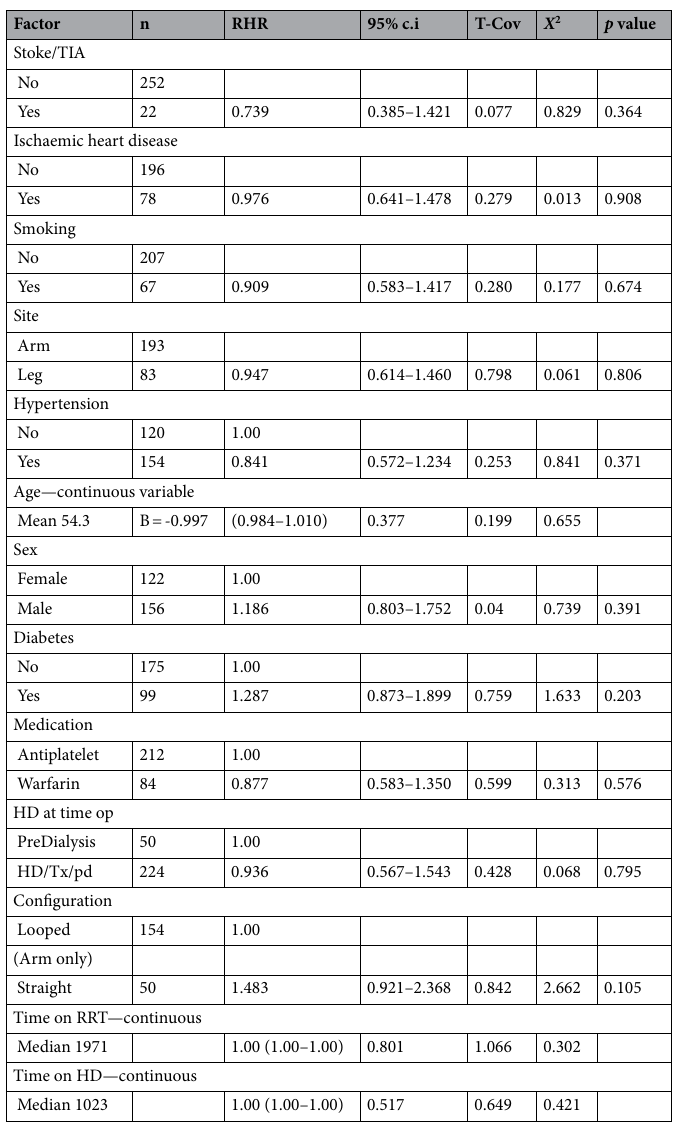
Table 3. Univariate analysis of risk of ecAVG survival (loss of functional patency): non-significant